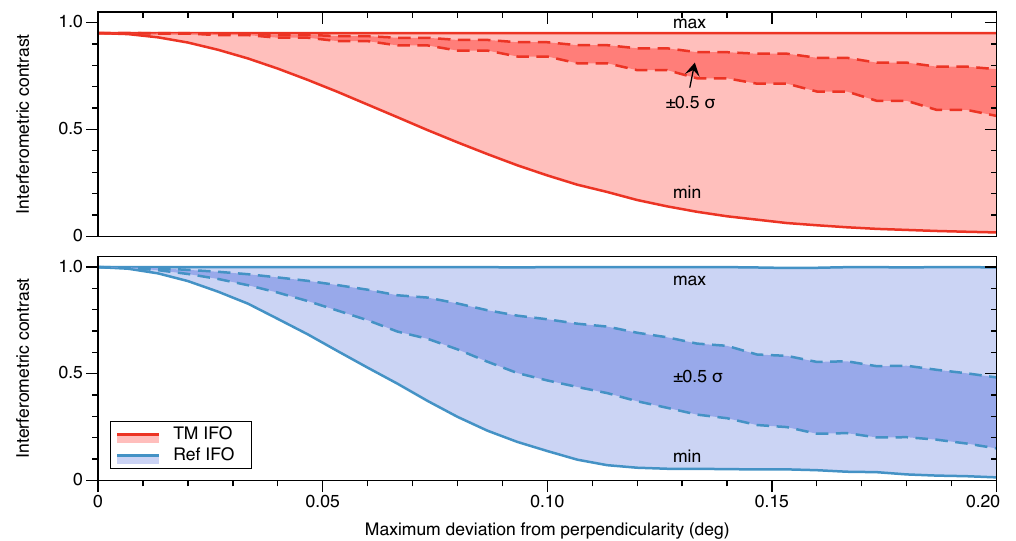
Figure 6. Sensitivity to manufacturing imperfections affecting the perpendicularity of the optical surfaces. The plots show the degradation of the interferometric contrast as a function of the amplitude of the uniform distribution of deviations from perpendicularity injected into all three optical surfaces of both interferometers. The number of Monte Carlo samples at each point is 1000. The dark-shaded area bordered by dashed lines corresponds to ± 0.5 σ , while the light-shaded region is bordered by continuous lines representing the maximum and minimum of the